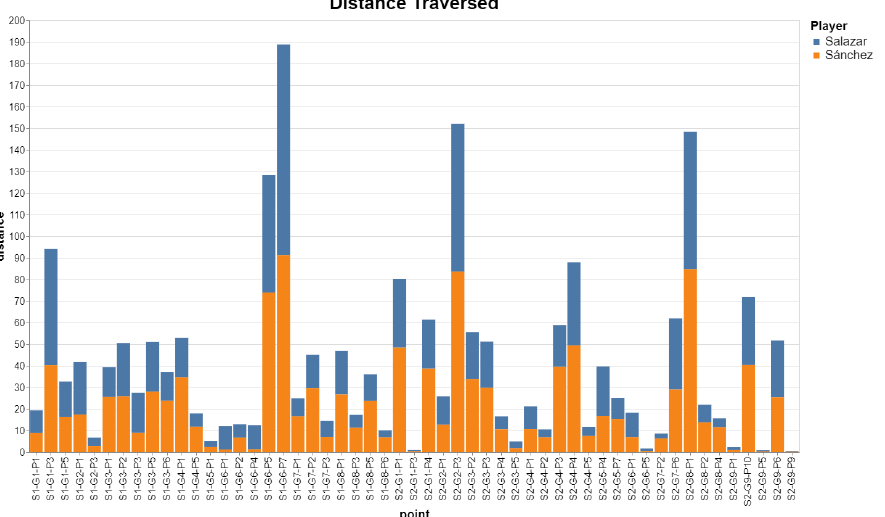
Figure 19. Distance traversed by the two players of a